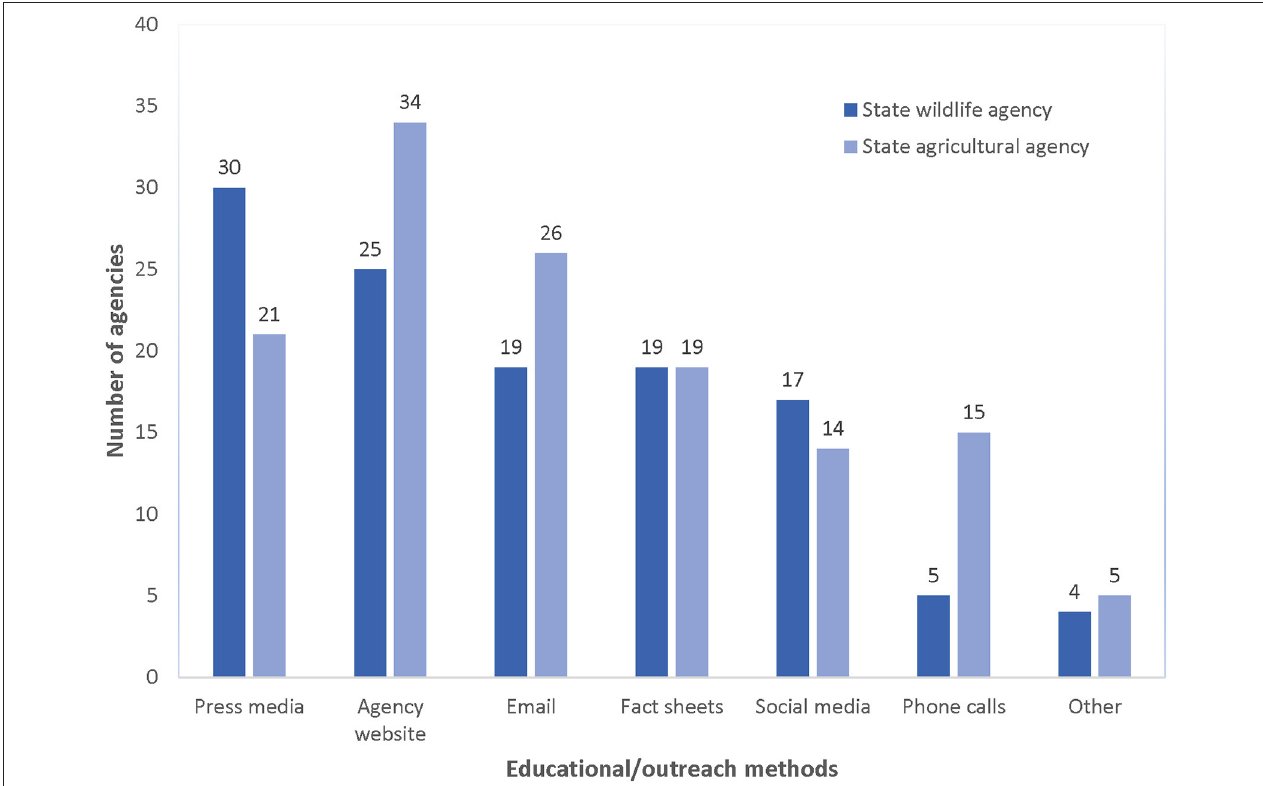
FIGURE 4 | Education strategies implemented by state agricultural ( n = 45) and wildlife agencies ( n = 50),